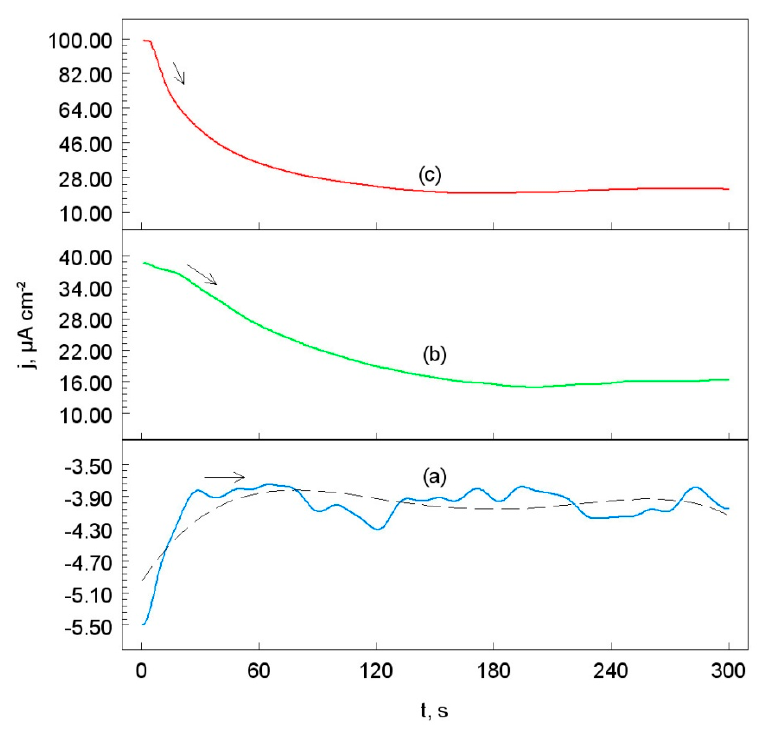
Figure 8. Chronoamperometric curves of Inconel 625 coating onto the S235JR substrate produced by laser cladding method with the use of powder, obtained for: (a) − 900 mV; (b) 830 mV, and (c) 960 mV. Solution contained 1.2 M Cl − , pH 1.5. (Dashed line refers to the average current density val- ues).